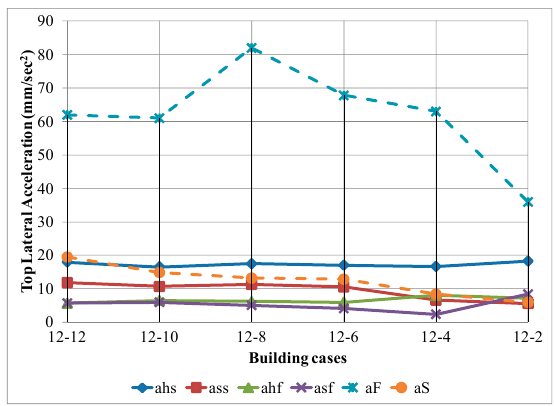
Figure 6. Top acceleration in x direction in buildings with different configurations.